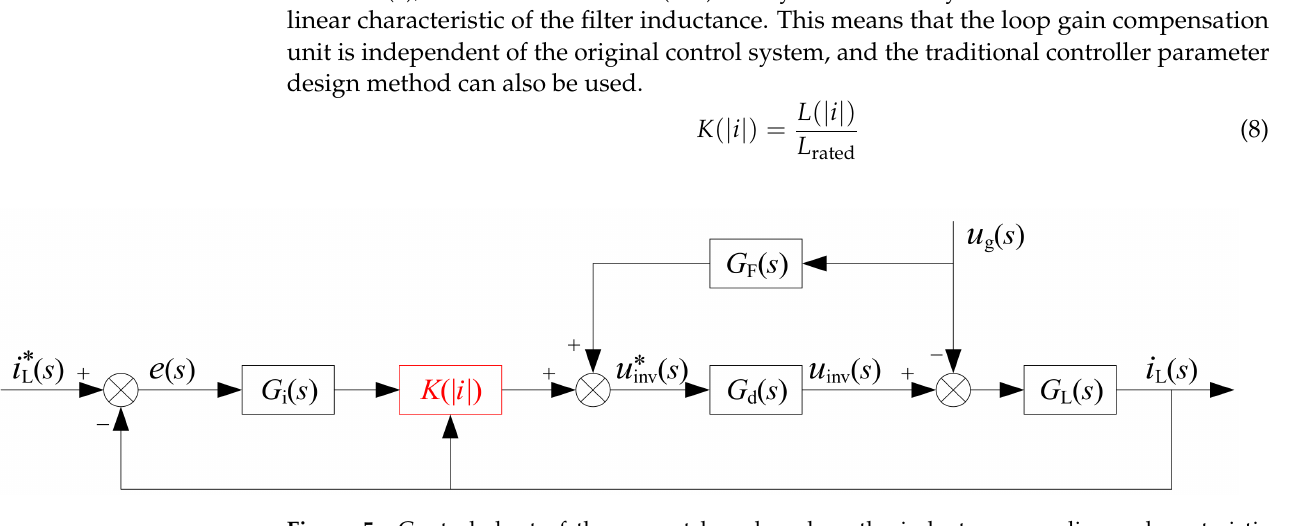
Figure 5. Control chart of the current loop based on the inductance non-linear characteristic